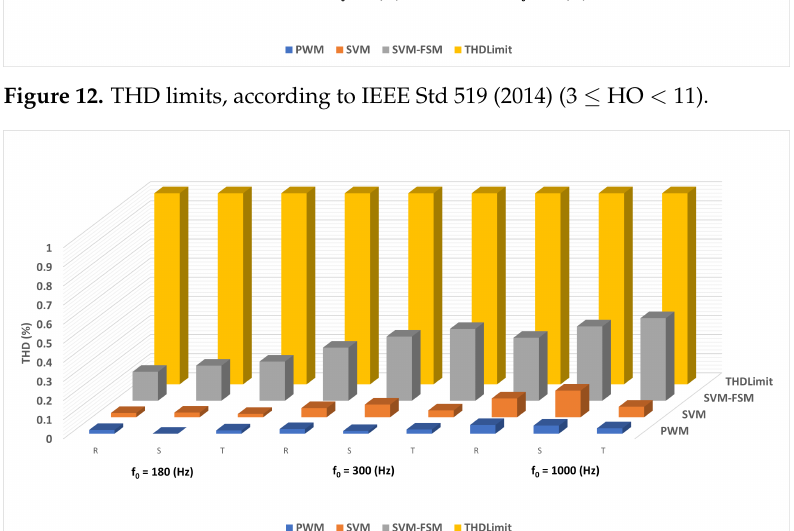
Figure 13. THD limits, according to IEEE Std 519 (2014) (11 ≤ HO <